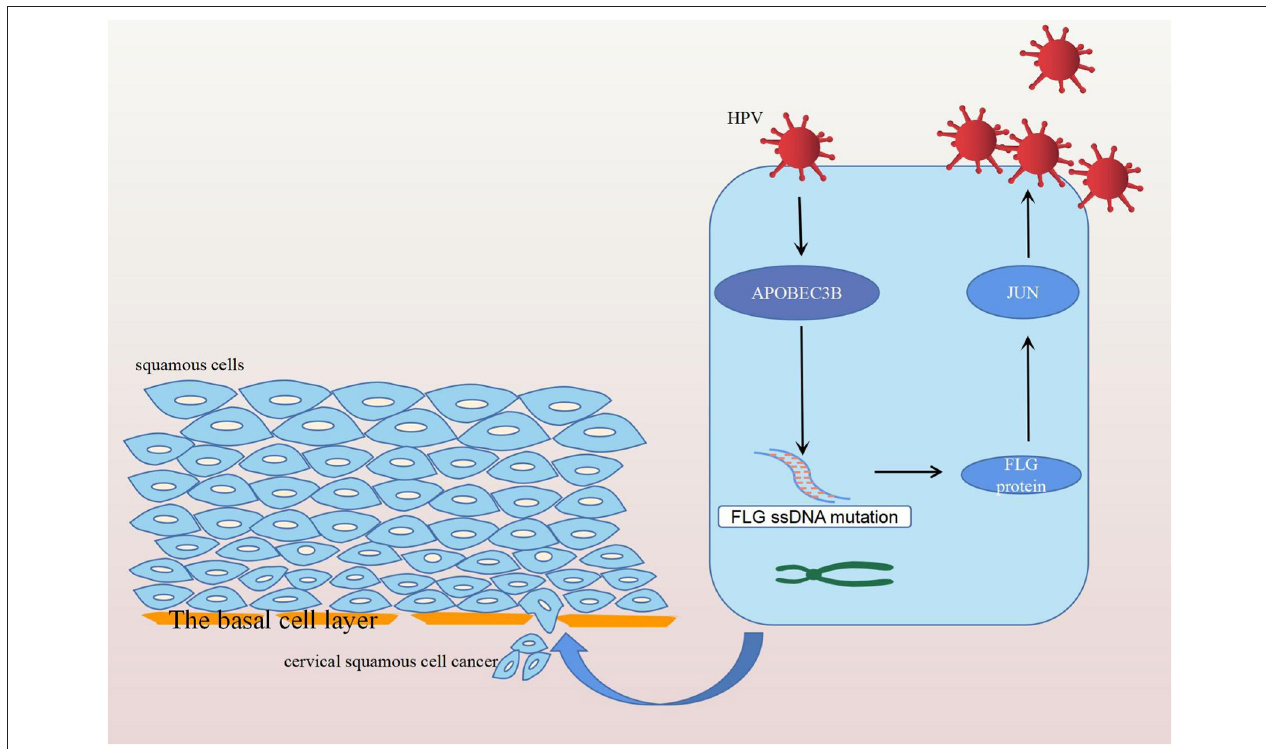
FIGURE 12 | Diagram of the mechanism of action of FLG gene mutation. Human papilloma virus infection stimulates the expression of APOBEC3B, which induces the APOBEC-related mutation of FLG ssDNA. The mutated FLG protein acts on JUN, resulting in its upregulation, and ultimately leading to the development and progression of